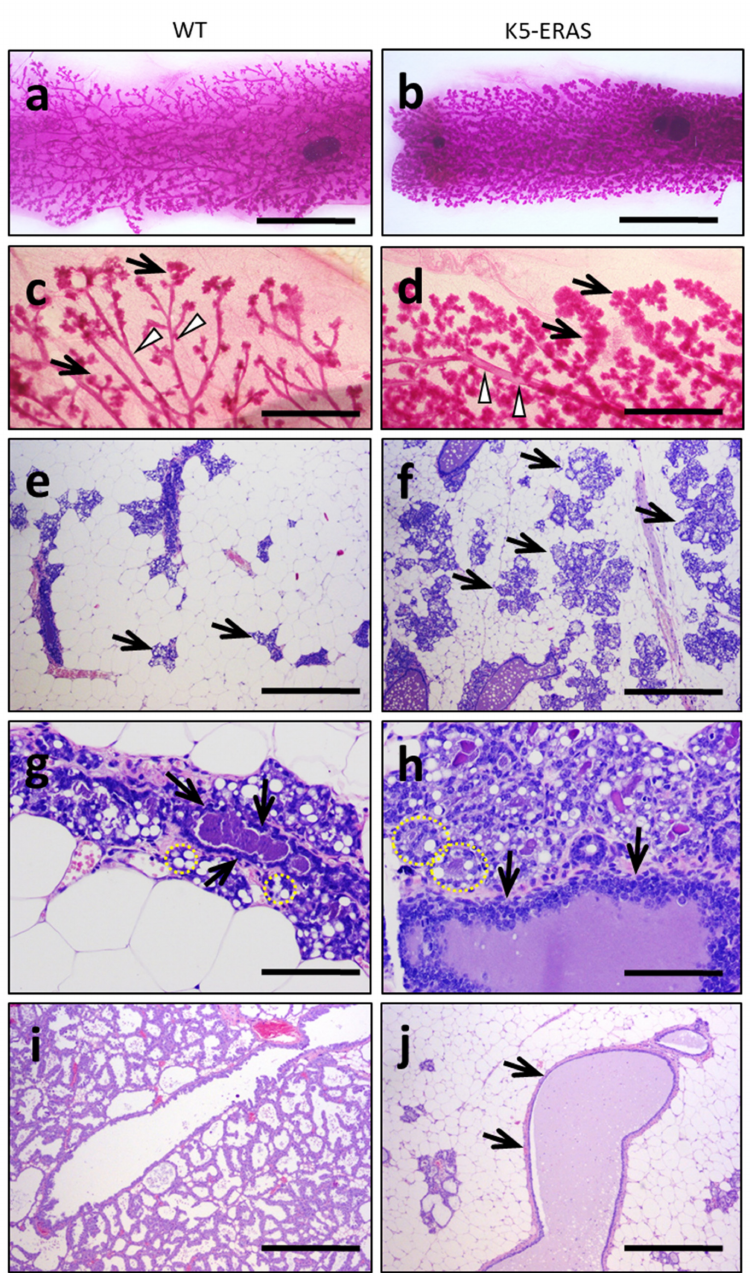
Figure 5. Morphological alterations in K5-ERAS mammary glands in pregnancy and lactation. ( a – d ) Whole mount carmine alum staining of mammary glands from WT ( a , c ) and K5-ERAS ( b , d ) female mice at a pregnancy age of 16.5 days. ( e – h ) H&E staining of WT ( e , g ) and K5-ERAS ( f , h ) mammary glands of 16.5 day-pregnant female mice. ( i , j ) H&E staining of lactating mammary glands